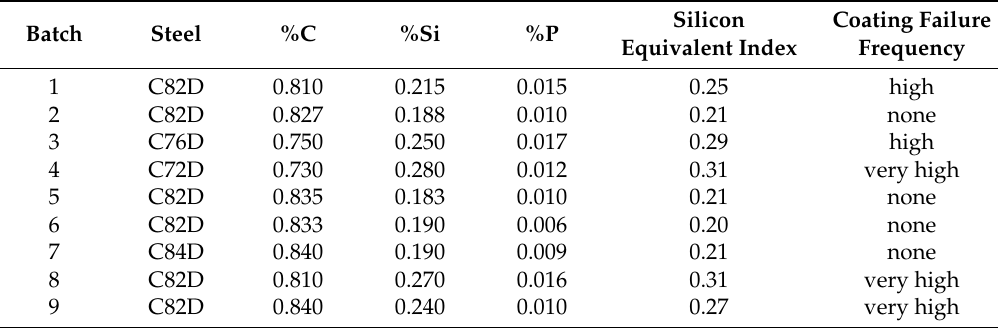
Table 3. Relationship between steel composition and wire Zn coating failure.